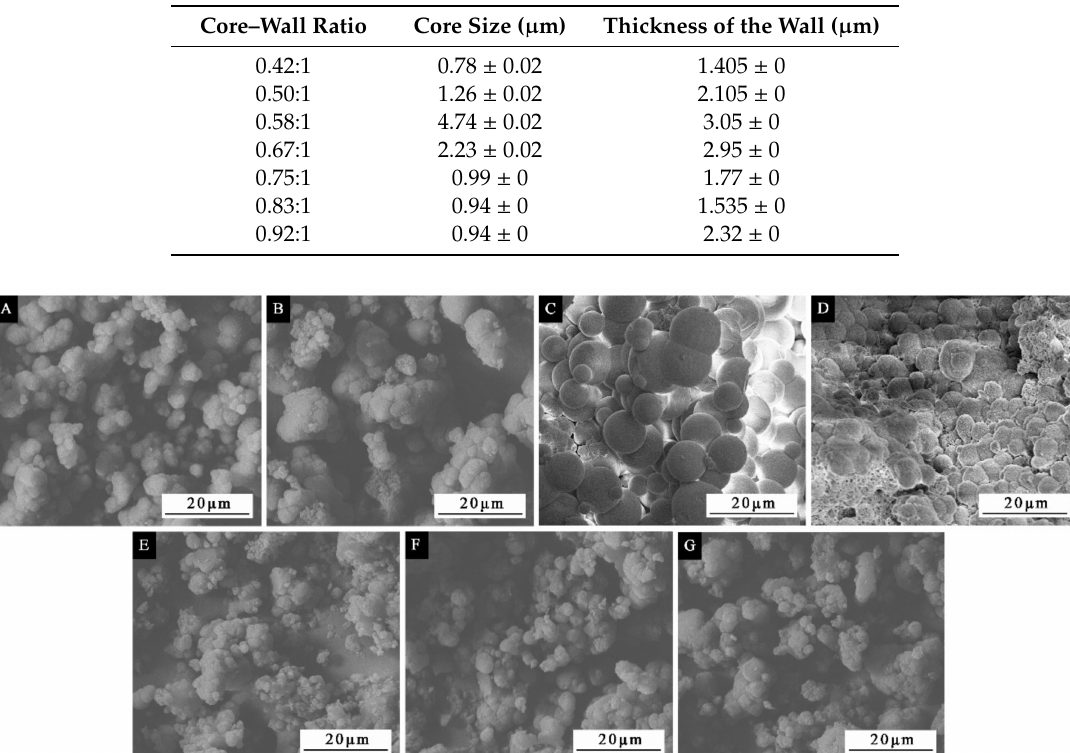
Table 3. Core Size and Thickness of the Wall of Microcapsules.